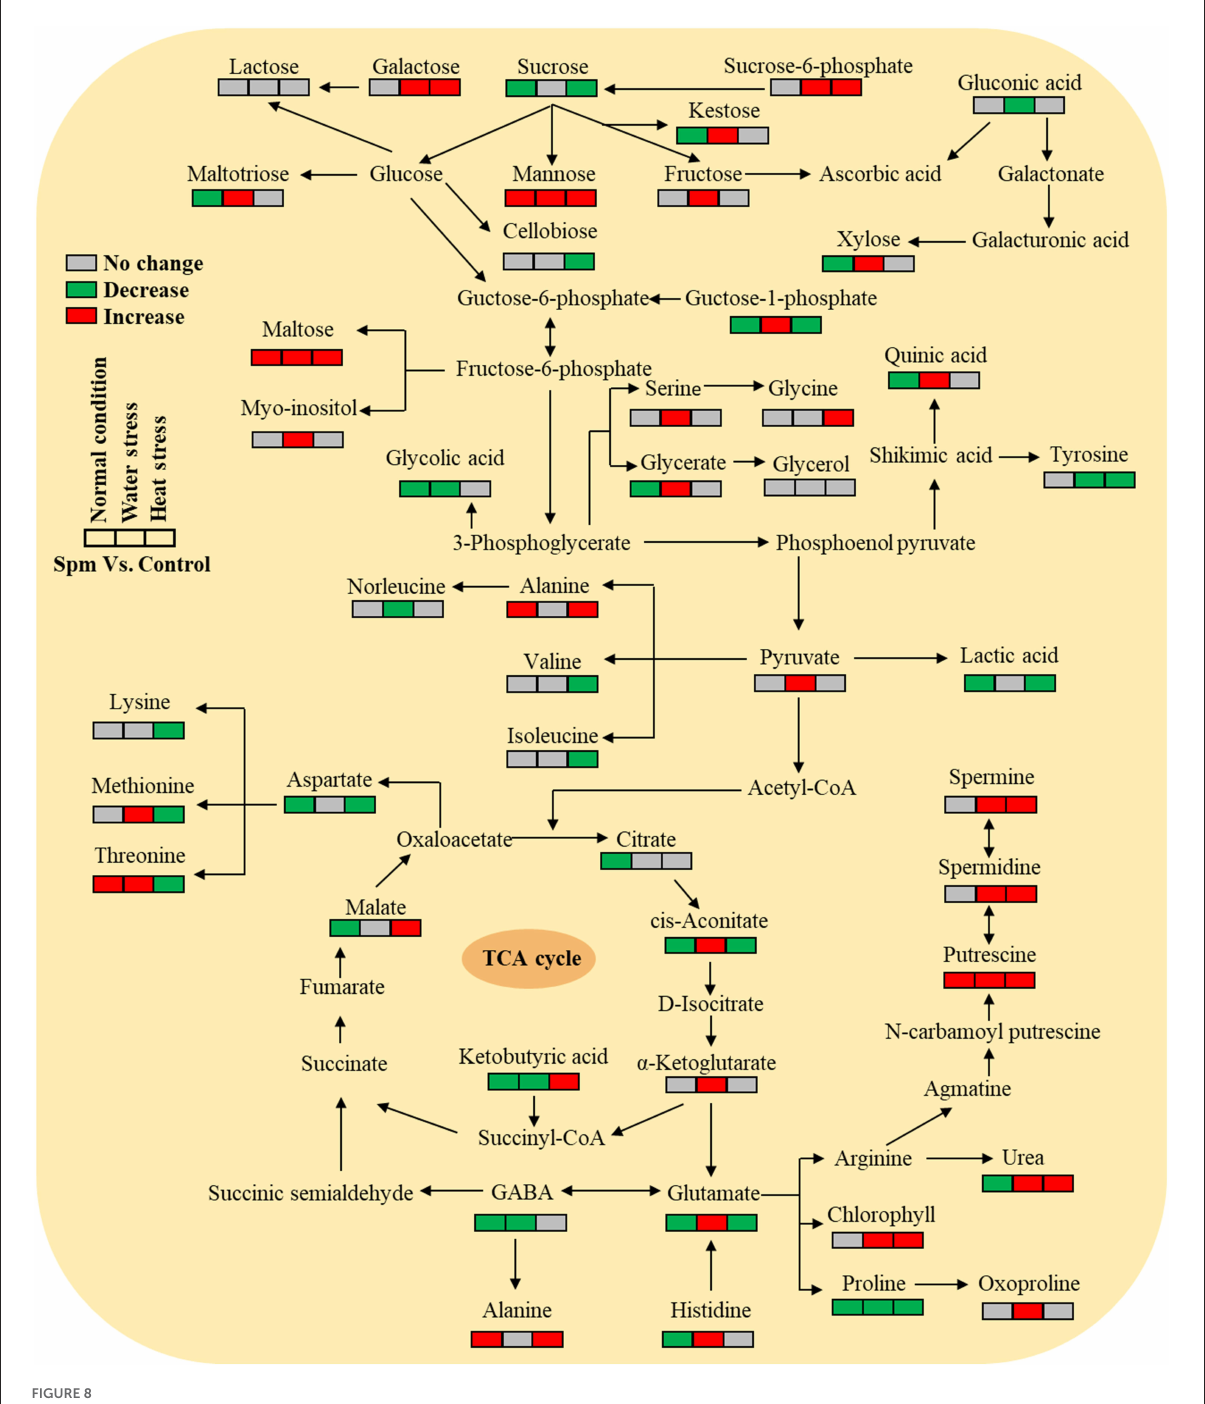
FIGURE8 Pathway enrichment analysis of 45 identified metabolites in leaves of creeping bentgrass regulated by spermine under the normal condition, water stress, and heat stress.